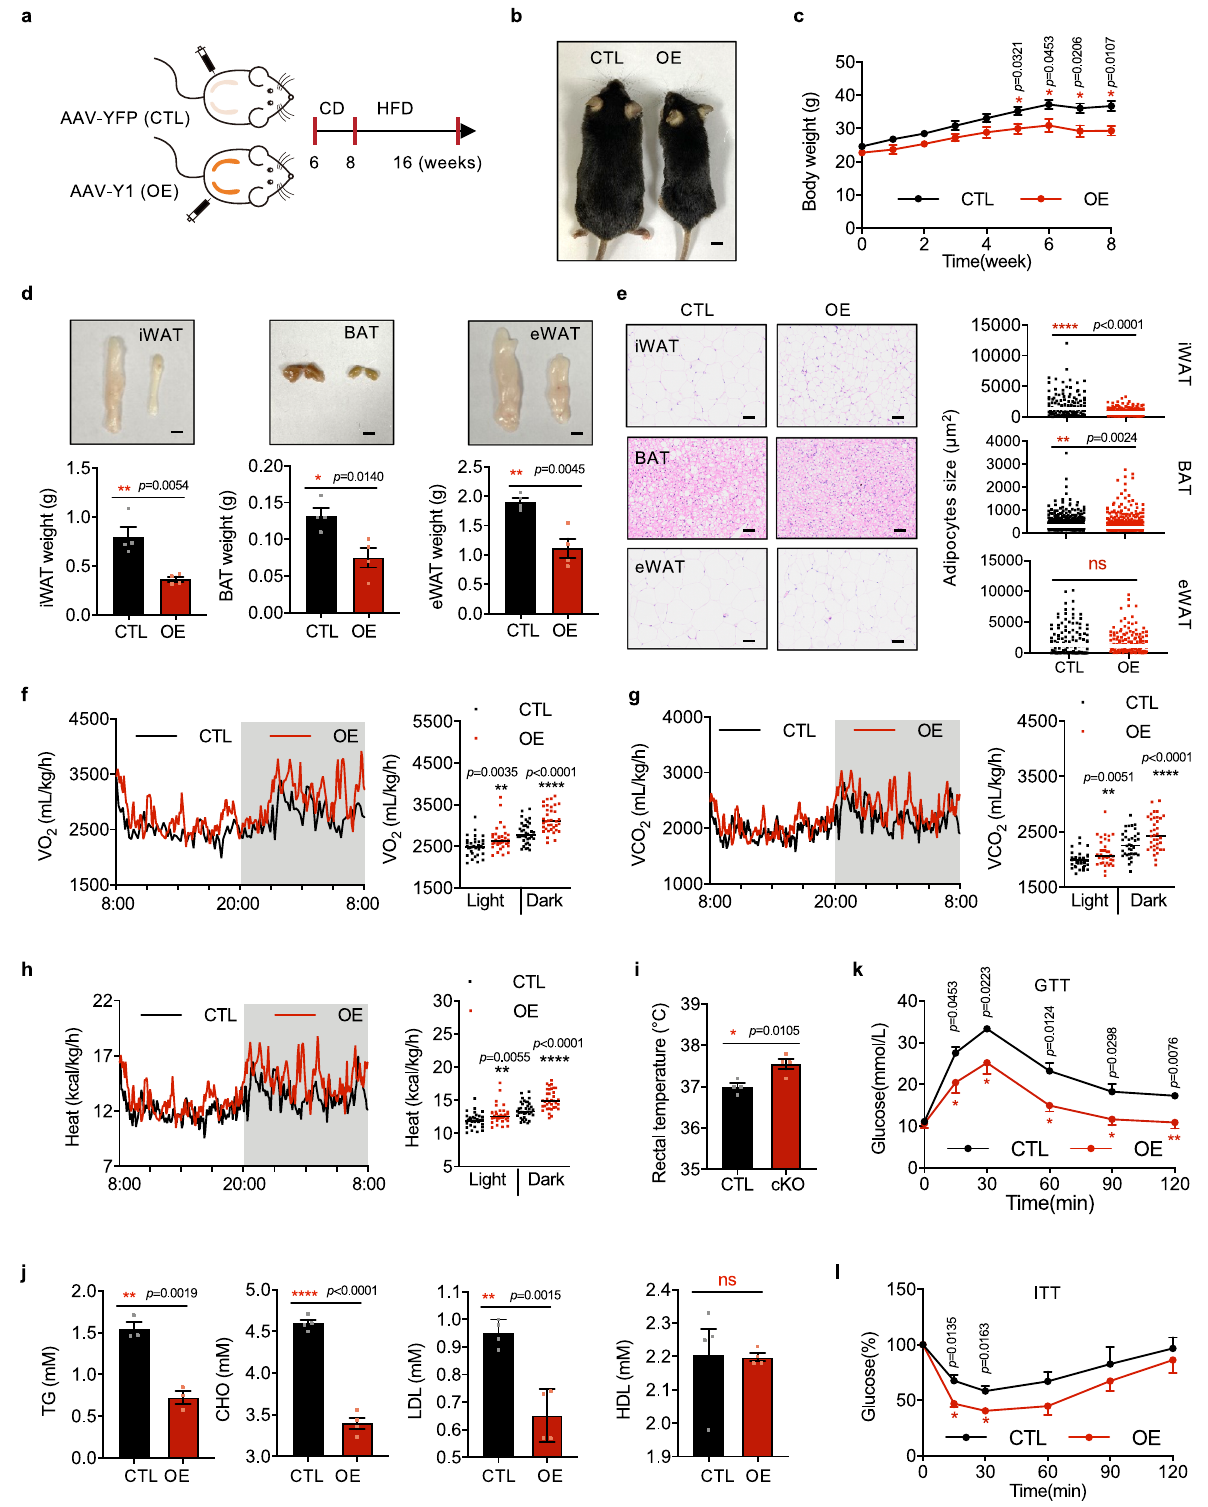
Fig.7|WAT-speci fi cYTHDF1overexpressionamelioratesHFD-inducedobesity. a Schematic of the mouse treatment regimen. b – l The AAV-CTL (CTL) and AAV- Y1 (OE) littermates were fed with HFD. b Gross view of CTL and OE mice. Scale bar, 0.5cm. c Body weights of CTL and OE mice. d Weights and gross view of iWAT, BAT, and eWAT from AAV-CTL and AAV-Y1 mice. Scale bar, 0.5cm. e H&E stainingofadiposetissue.Scalebar,50 μ m.Thewhitelineindicatedtheaverage size. f – h O 2 consumption f , CO 2 generation g , and energy heat generation h of